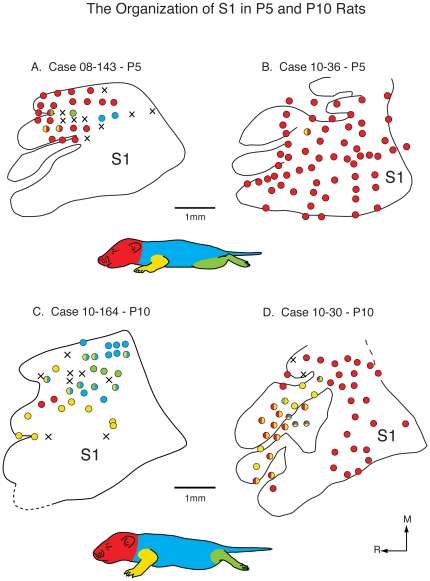
Functional S1 maps in P5 and P10 rats.Reconstructed functional maps of primary somatosensory cortex in P5 (A and B) and P10 (C and D) rats. A schematic of a rat body is divided into different major sections: the head, portions of the face and the vibrissae are red, the trunk and tail are blue, the forelimbs are yellow, and the hindlimbs are green. Recording sites that contained neurons that had receptive fields on these major parts are shown as circles filled with that color (i.e., yellow). Recording sites that contained neurons that responded to multiple body parts are labeled with the colors of all of the corresponding body parts. Recording sites that did not respond to any somatosensory stimulation are marked with an X. At P5, medial portions of S1 that normally represent portions of the limbs and trunk contain representations of the face/vibrissae with only a few sites containing neurons responsive to stimulation of the contralateral body. By P10, representations of body parts are beginning to emerge. Conventions as in previous figures.